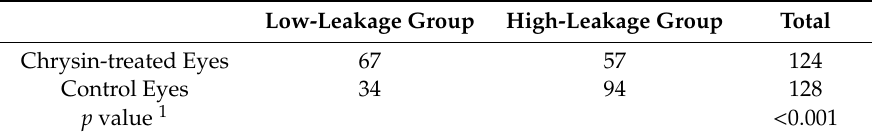
Table 2. Number of CNV lesions in the low-leakage and high-leakage groups.